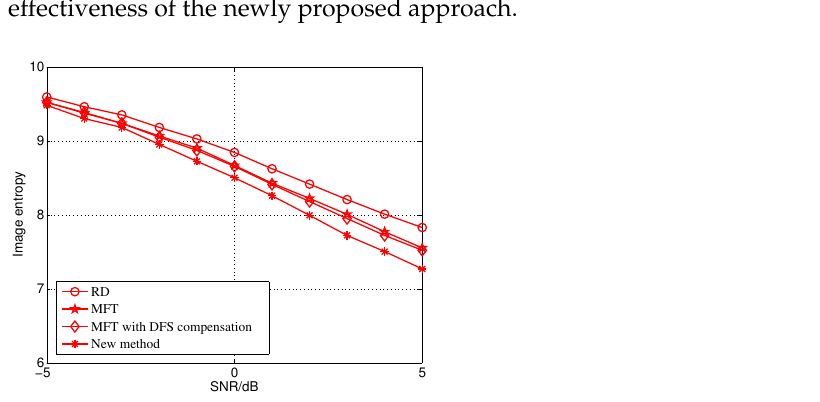
Figure 7. Variation of average image entropy with SNR by using different